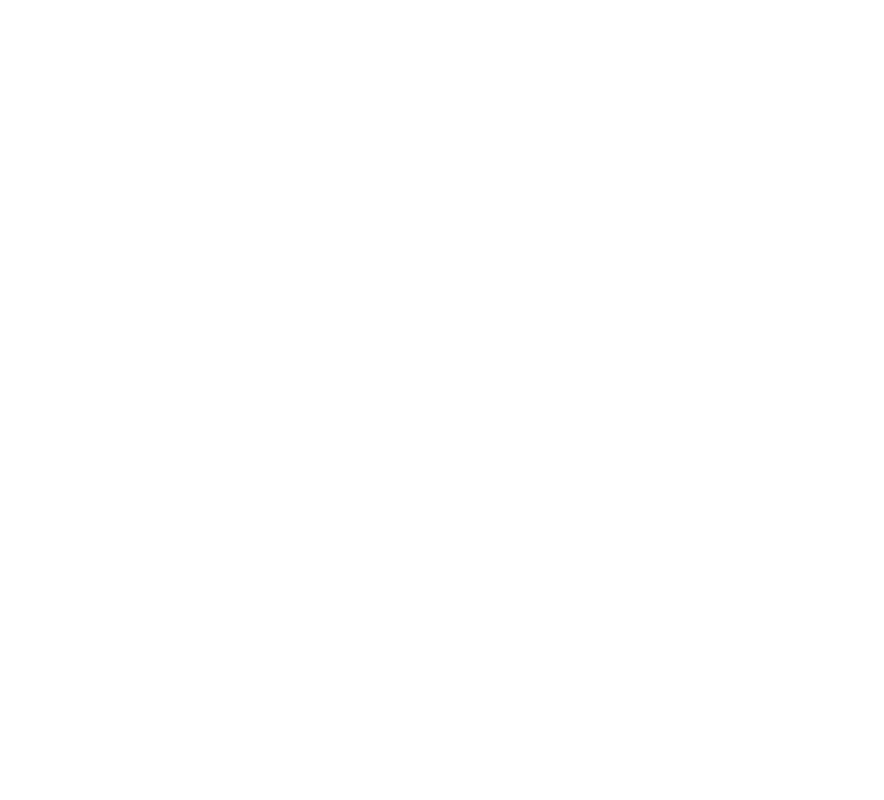
FIGUREA2 |A heat map plot of the methylation and gene expression values for each subject in the